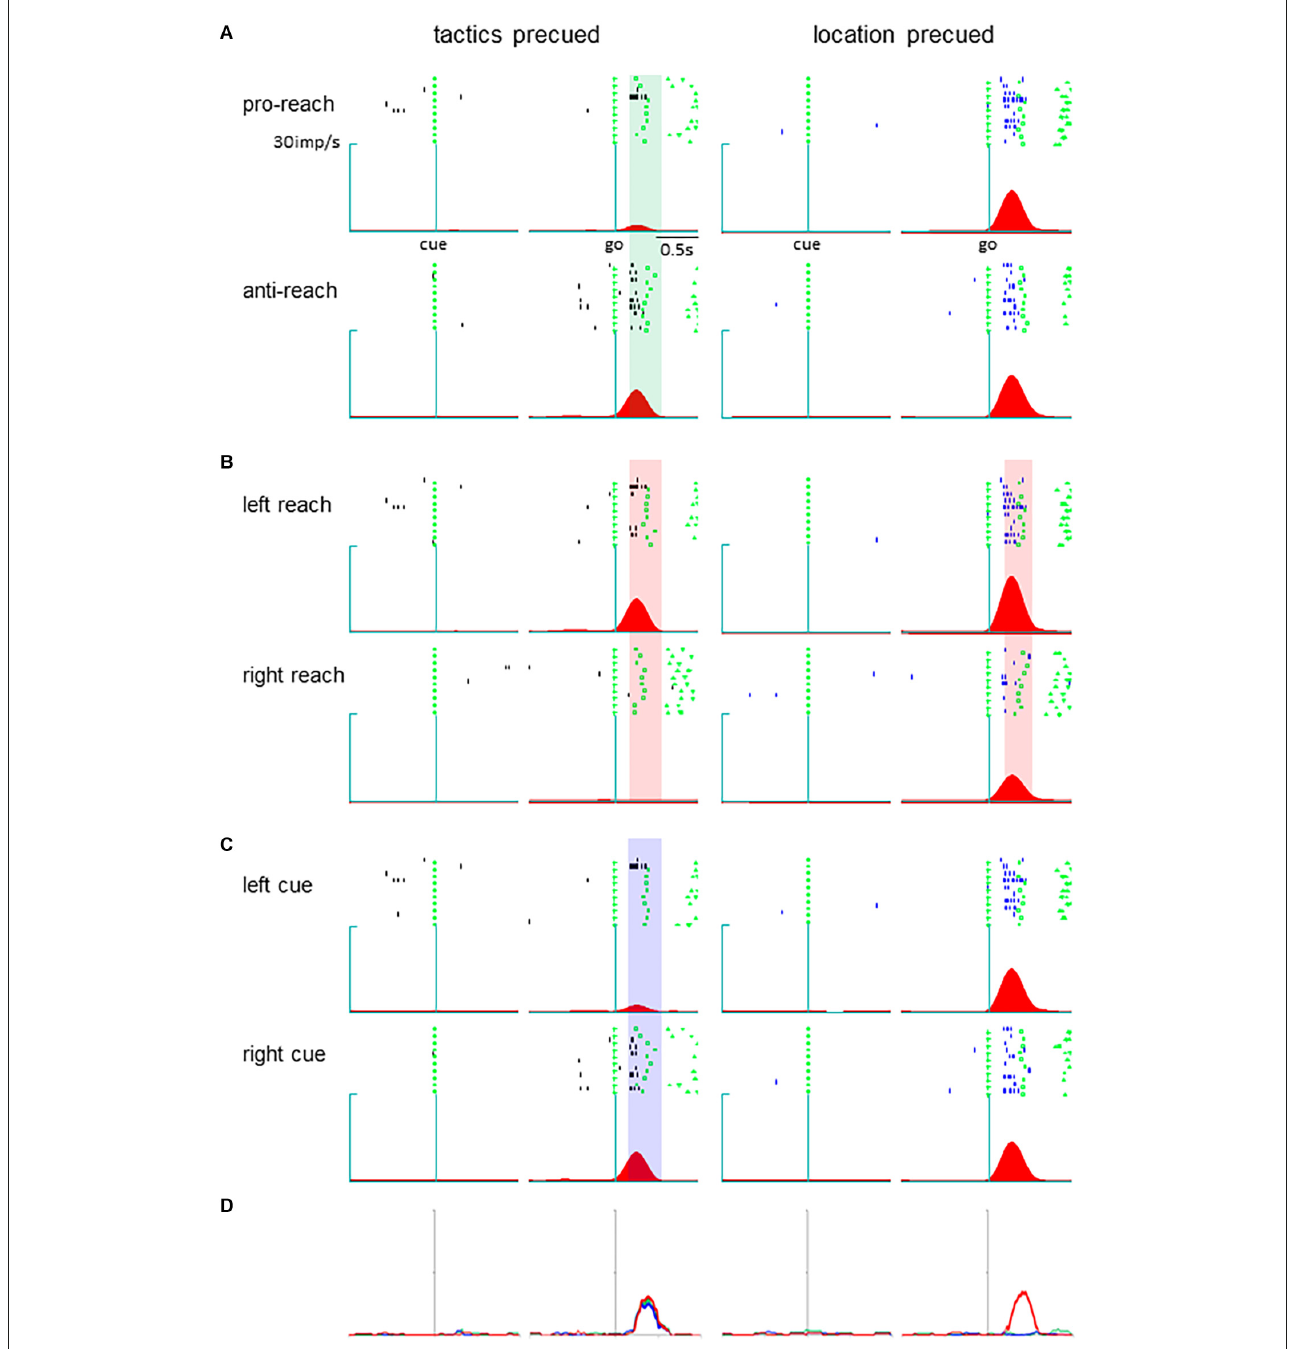
FIGURE2 A pmPFC neuron encoding different information across different tasks during the delay period. (A–C) Raster display and spike density function of the neuronal activity. The trials are grouped by tactics (A) , action (B) , and cue location (C) . Activity during the tactics- and the location-precued tasks are shown in the left and the right columns, respectively. In each column, trials are aligned with cue onset (left) and go signal onset (right). The shaded areas are the time intervals where the tactics (A) , action (B) , and cue location (C) had significant effect on the neuronal activity. (D) The temporal variance of tactic selectivity (green color), action selectivity (red color), and cue location (blue color) illustrated as time-resolved change in the coefficient of partial determination (CPD) value. The thick line indicates significant effect of the respective factor on IFR( t ) ( p < 0.05 by ANOVA). Left : tactics-precued task, right : location pre-cued